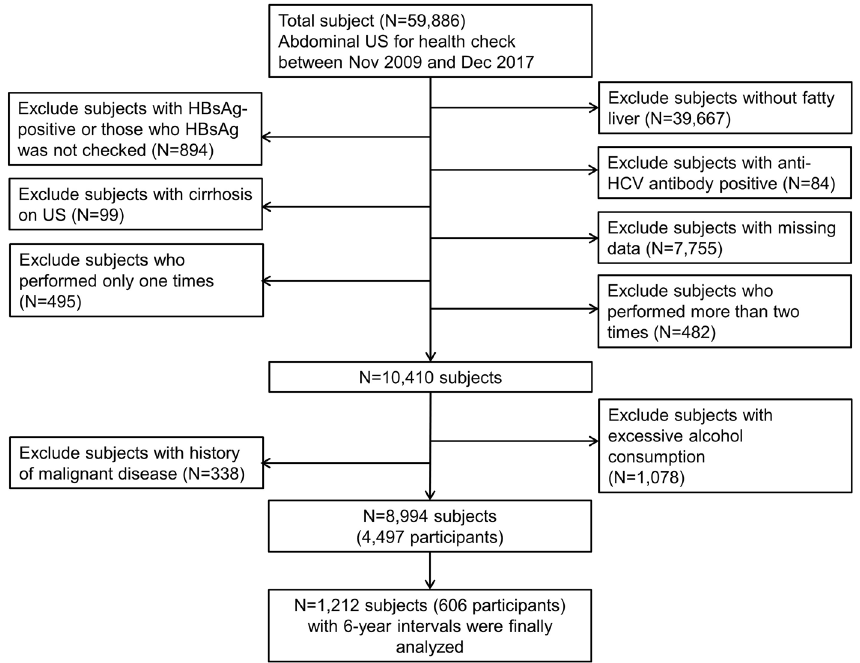
Figure 1. Flowchart for the composition of the study